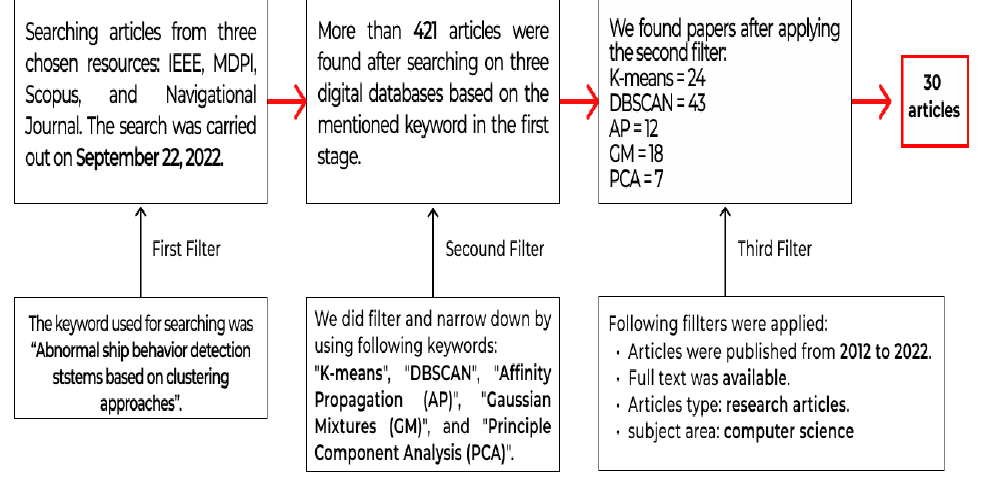
Figure 2. The steps of literature review